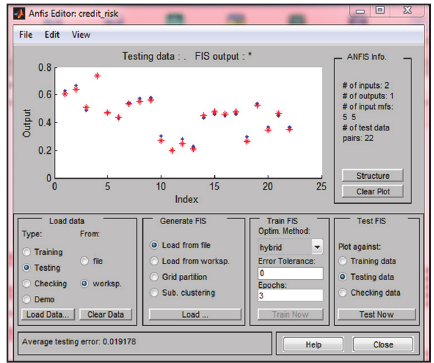
Fig. 5. The Output of Market Risk Neuro-Fuzzy Network for Testing